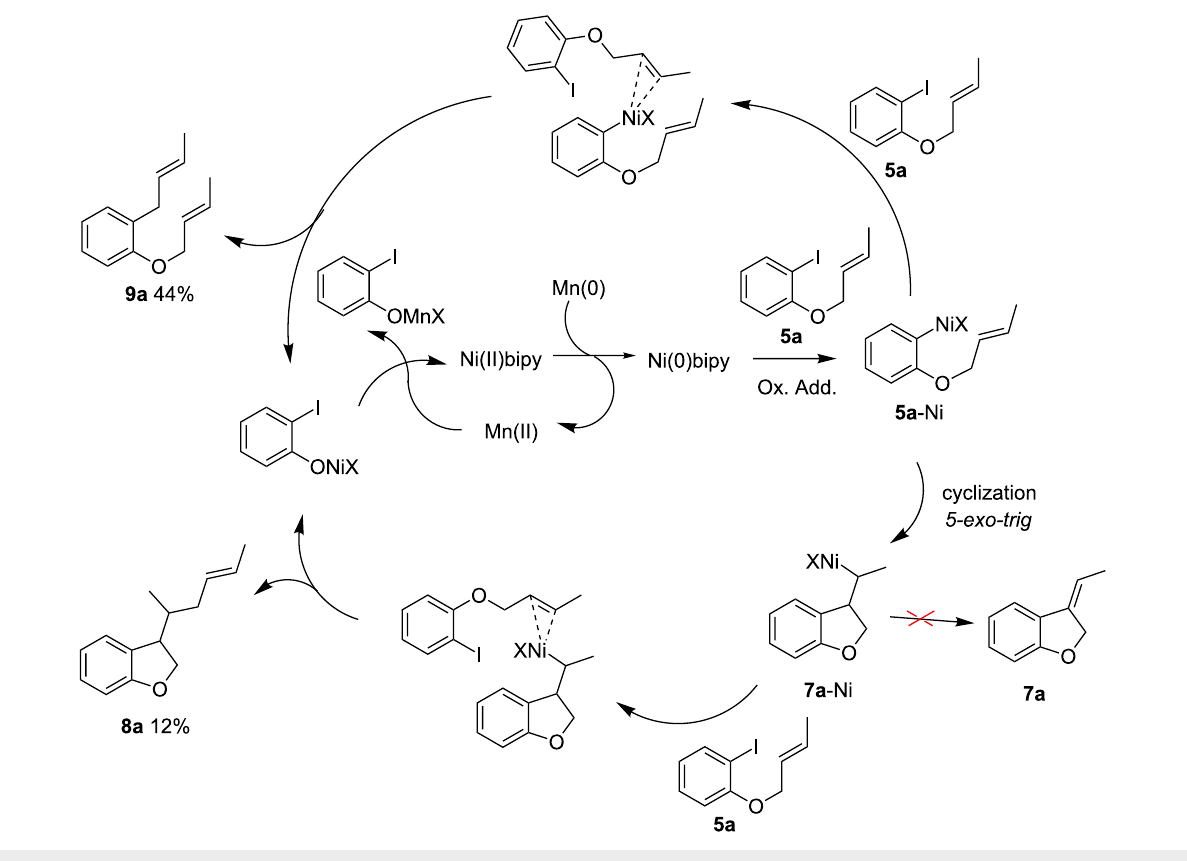
Scheme 4: Proposed mechanism involving π -allylnickel formation.